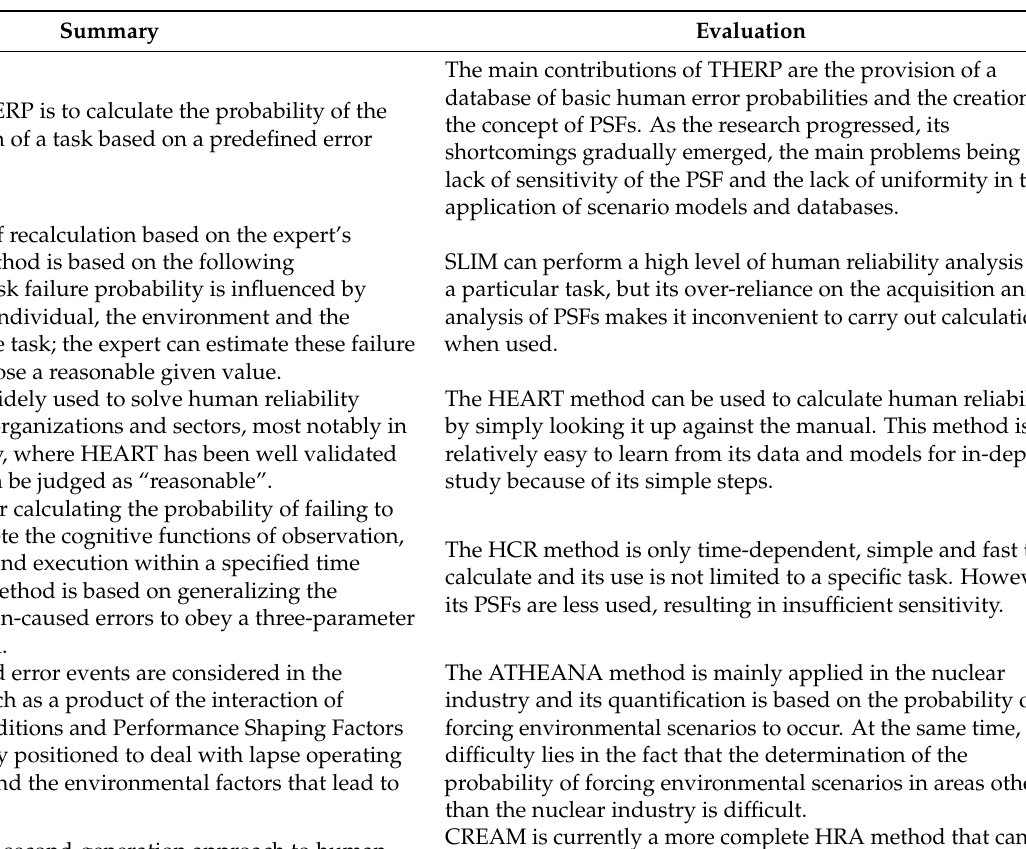
Table 1. Human reliability analysis (HRA)